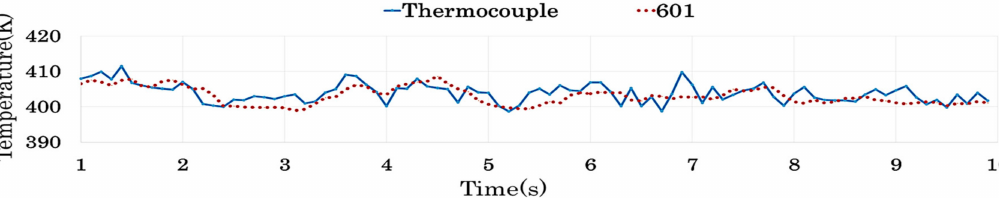
Figure 10. Comparison of T Thc and T Rec for 601 cycles.